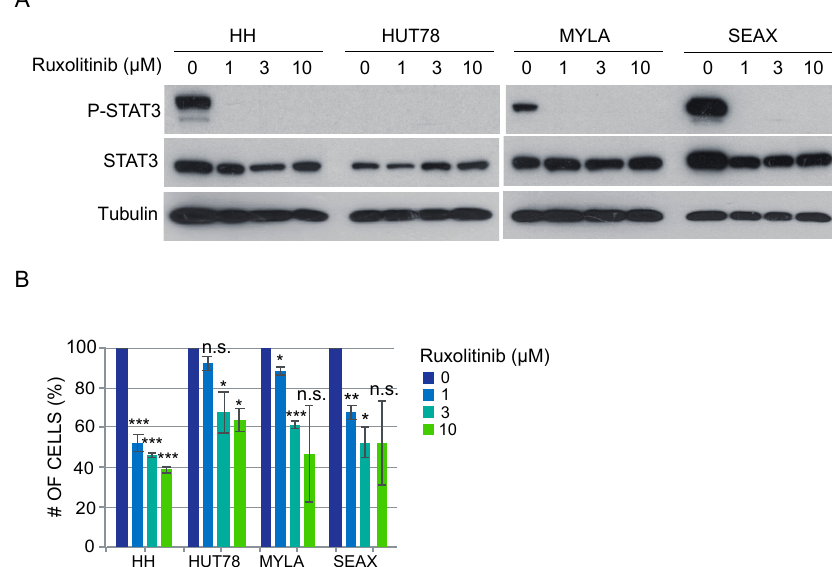
Figure 4. Sensitivity of CTCL cells to pharmacologic JAK/STAT inhibition. Dose–response assay in CTCL cells using the JAK/STAT pathway inhibitor Ruxolitinib. ( A ) low inhibitor doses completely precluded JAK/STAT activation in CTCL as indicated by the absence of p-STAT3; ( B ) Analysis of cell number after 48 h of Ruxolitinib treatment indicated highest sensitivity of HH and SeAx cells, which contain bigger amounts of STAT3 and p-STAT3 under basal conditions. The graph represents the average value and standard deviation of two independent experiments. Statistical significance was calculated by an unpaired t -test. *** p < 0.001, ** p < 0.01, * p < 0.05, n.s. = non-significant.